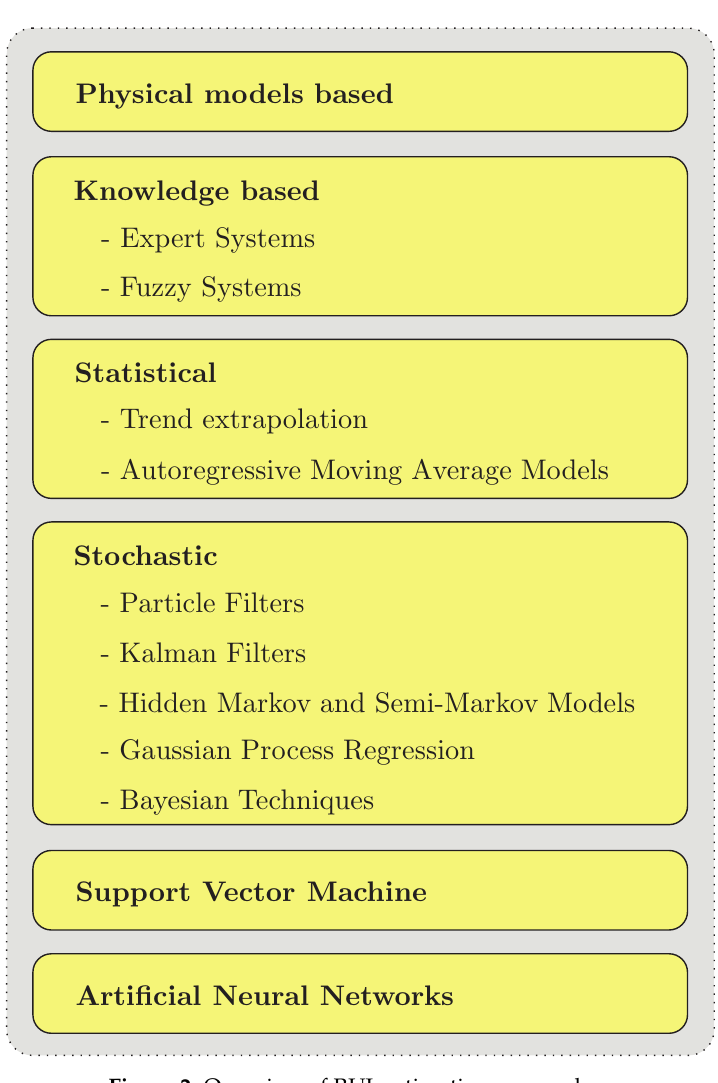
Figure 2. Overview of RUL estimation approaches.